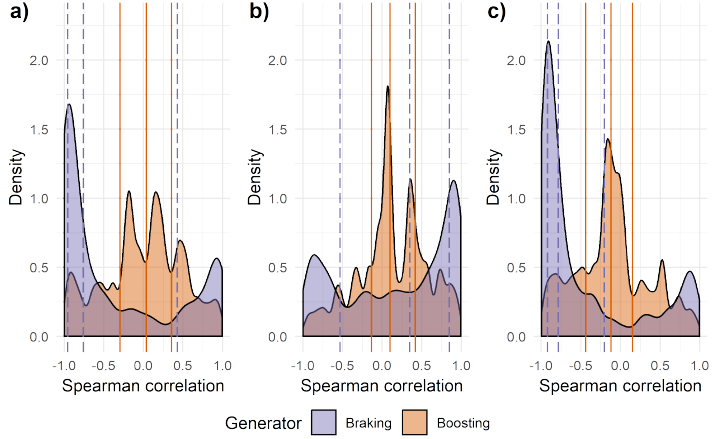
Figure 6. Density plot of the spearman correlation of ISO.14 in respect to the exponentially smoothed generator speed by wind turbine, vertical lines represent quartiles. ( a ) WT 1, ( b ) WT 2 and ( c ) WT